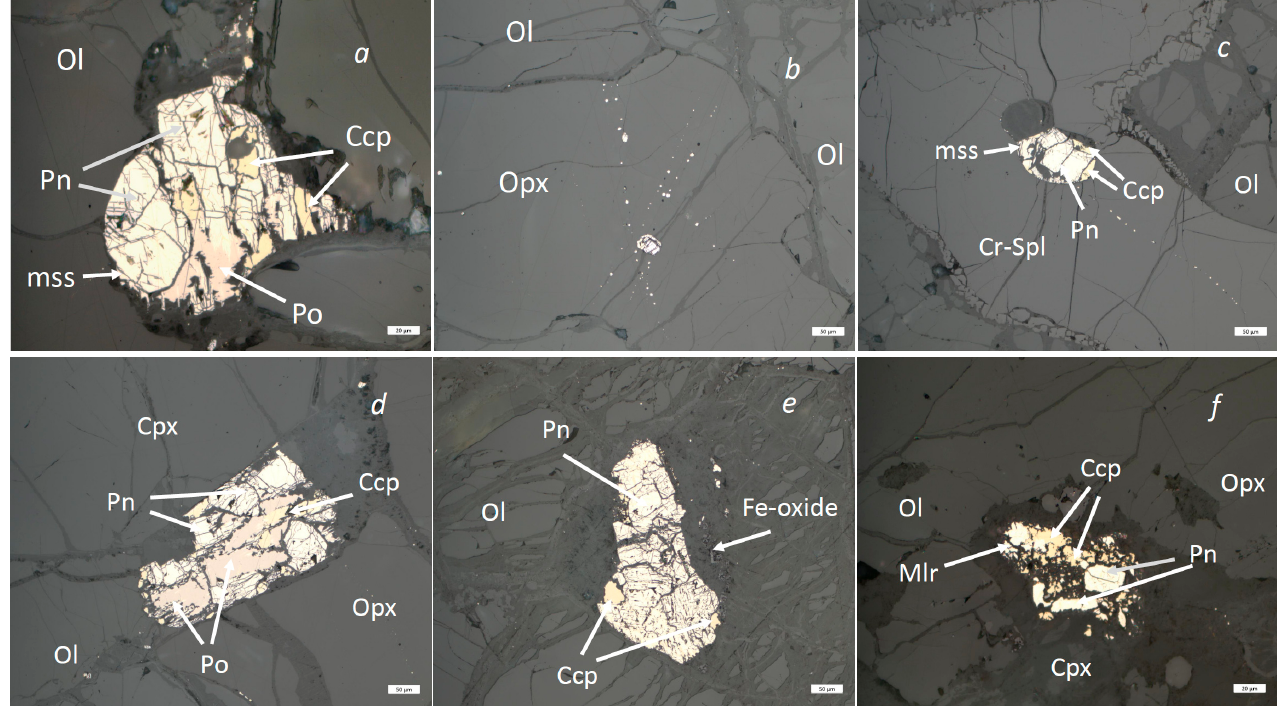
Figure 4. Reflected light photomicrographs of sulfide structural type from Cpx-rich Spl lherzolites: ( a ) three-phase roughly rounded sulfide inclusion (e-type) in Ol. The main body consists of Pn with only insignificant presence of Ccp along the cleavage cracks. Partly preserved pyrrhotite (Po) displays flame-like relations between Pn and Po. Massive Ccp is developed inside the Pn body and at the edges of the inclusion. The scale bar is 20 μ m; ( b ) chains of multiple tiny sulfide inclusions (e-type) in Opx developed along the healed cracks in the host mineral. The scale bar is 50 μ m; ( c ) oval sulfide inclusion (e-type) in the Spl grain (resorbed edges of the grain are seen). The main volume of the inclusion consists of cleaved Pn with insignificant presence of Ccp along the cleavage cracks. Massive Ccp is developed at the edges of the inclusion. A small mss bleb is present at the edge of the inclusion. Chains of tiny sulfides are located along the existing and healed cracks in Spl. The scale bar is 50 μ m; ( d ) irregular three-phase interstitial (i-type) sulfide grain. The main volume consists of Pn + Po often displaying flame-like relations. Ccp forms lamellae along cleavage cracks in Pn. Massive Ccp is developed inside and at the edges of the sulfide grain. The scale bar is 50 μ m; ( e ) bi-mineral irregular interstitial (i-type) Pn + Ccp grain with strongly cleaved Pn core and massive Ccp at the edges of the grain. Ccp is sometimes exsolved along the cleavage cracks in Pn. Tiny crystals of Fe-oxides are developed around the sulfide grain. The scale bar is 50 μ m; ( f ), resorbed interstitial (i-type) sulfide resulting from the mss breakup. Sulfide consists of equal amounts of massive Pn and resorbed Ccp. Rare patches of Mlr are developed at the edges of sulfide grain. The scale bar is 20 μ m.